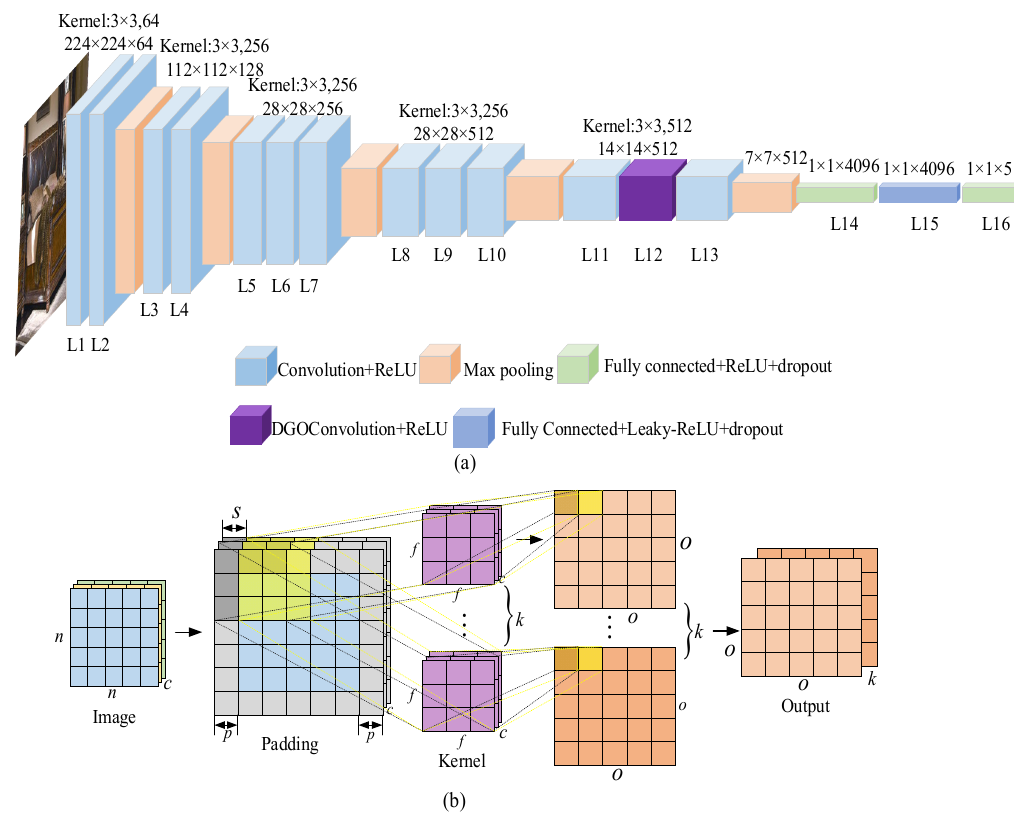
Figure 4. The designed DGVGG16 model details of each convolutional layer ( a ) DGOVGG16 struc- ture. ( b ) convolution processing. ( b ) convolution